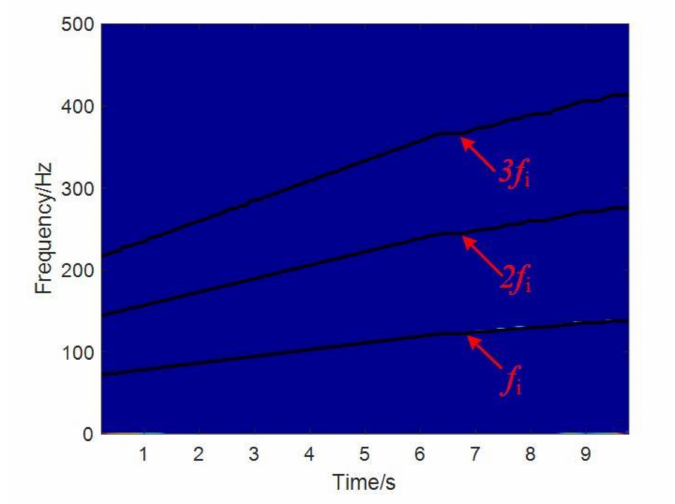
Figure 18. The result provided by the proposed method using